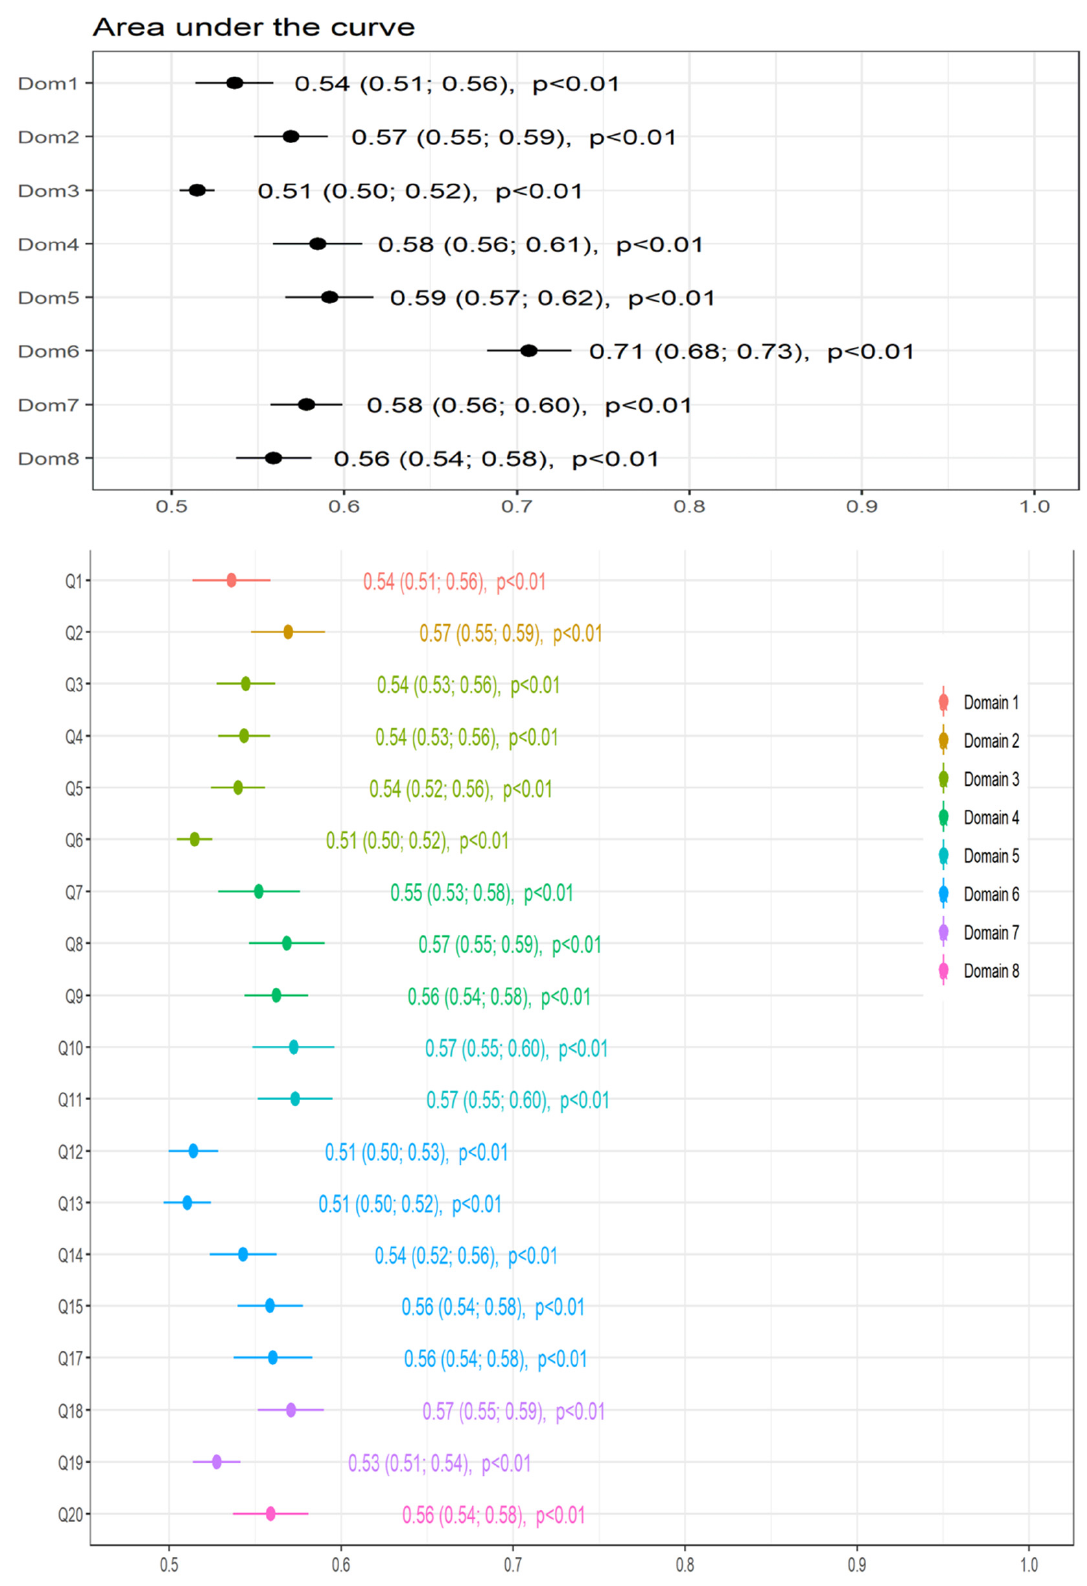
Figure 3. The area under the curve (AUC) from the receiving operating characteristics curve (ROC) for the scores of each domain (upper panel) and each question (lower panel) of the CFVI-20 questionnaire. Question 16 was not included due to its superimposed effect on the dependent